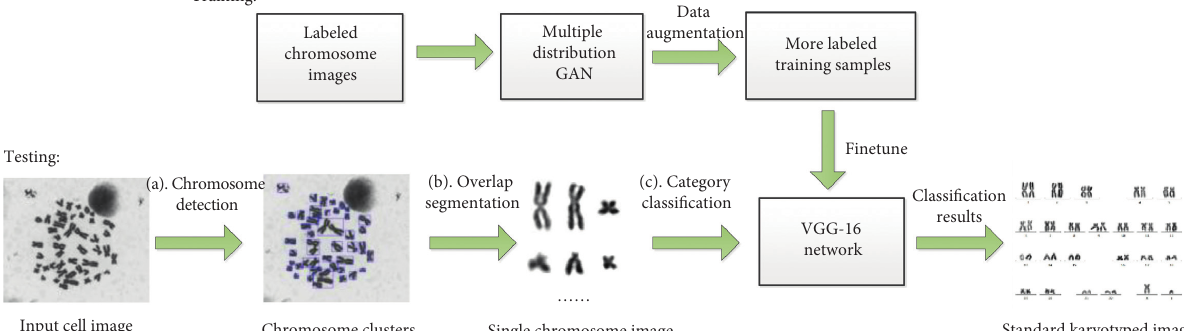
Figure 3: Pipeline for our chromosome karyotyping method: (a) detecting chromosome candidates with ER technology and various filters, (b) segmenting overlap or touching chromosome clusters into individual ones with the proposed segmentation tool, (c) first utilizing MD- GAN to perform data augmentation and then finetuning pretrained CNN with more training samples to classify chromosome category of individual chromosomes. Classification results are finally sorted as a standard karyotyped image.